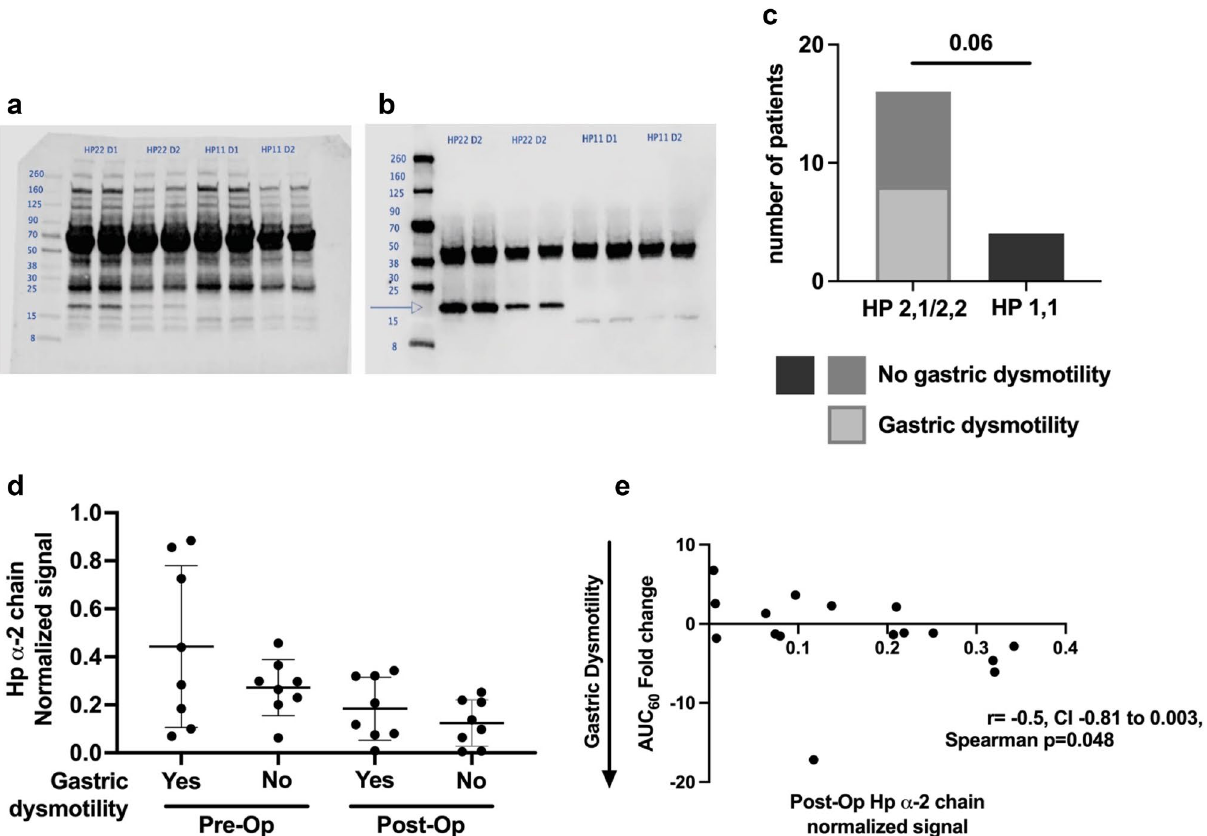
Figure 1. Haptoglobin (HP) α-2 chain and gastric dysmotility in patients. Panels ( a ) and ( b ) are representative Western Blots for the HP α-2 chain. Panel ( a ) is the total protein staining for quantification using LI-COR’s Revert 700 Total Protein Stain. Panel ( b ) is the corresponding membrane incubated with the primary antibody for HP. Three potential bands are expected, a ~ 45 kDa band for the β-chain that is present in all HP types and two potential α-chains, a ~ 8.9 kDa α-1 chain and a ~ 16 kDa α-2 chain. Subjects were HP typed, as designated above the lanes, based on the presence of the two potential α chains. The α-2 chain, when present, is also noted by an arrow. All subject samples were run in duplicate and LI-COR Chameleon Duo ladder was utilized for all membranes. Membranes were read in the LI-COR Odyssey. Panel ( c ) Distribution of the HP isotypes. Sixteen subjects carried at least one copy of the α-2 chain and 4 subjects carried no α-2 chain copies. Eight subjects developed post-operative gastric dysmotility, all of whom carried at least 1 copy of the HP α-2 chain. Panel ( d ) Normalized signal for the HP α-2 chain distribution. Panel ( e ) Higher normalized signal for the HP α-2 chain correlated to greater decrease in the area under the curve at 60 min (AUC60) post-operatively compared to pre- operative values in subjects undergoing surgery and requiring critical care.